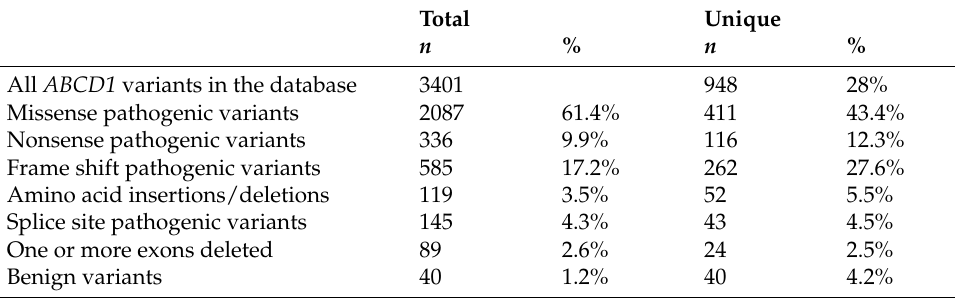
Table 1. Variant Counts and Frequencies in ABCD1